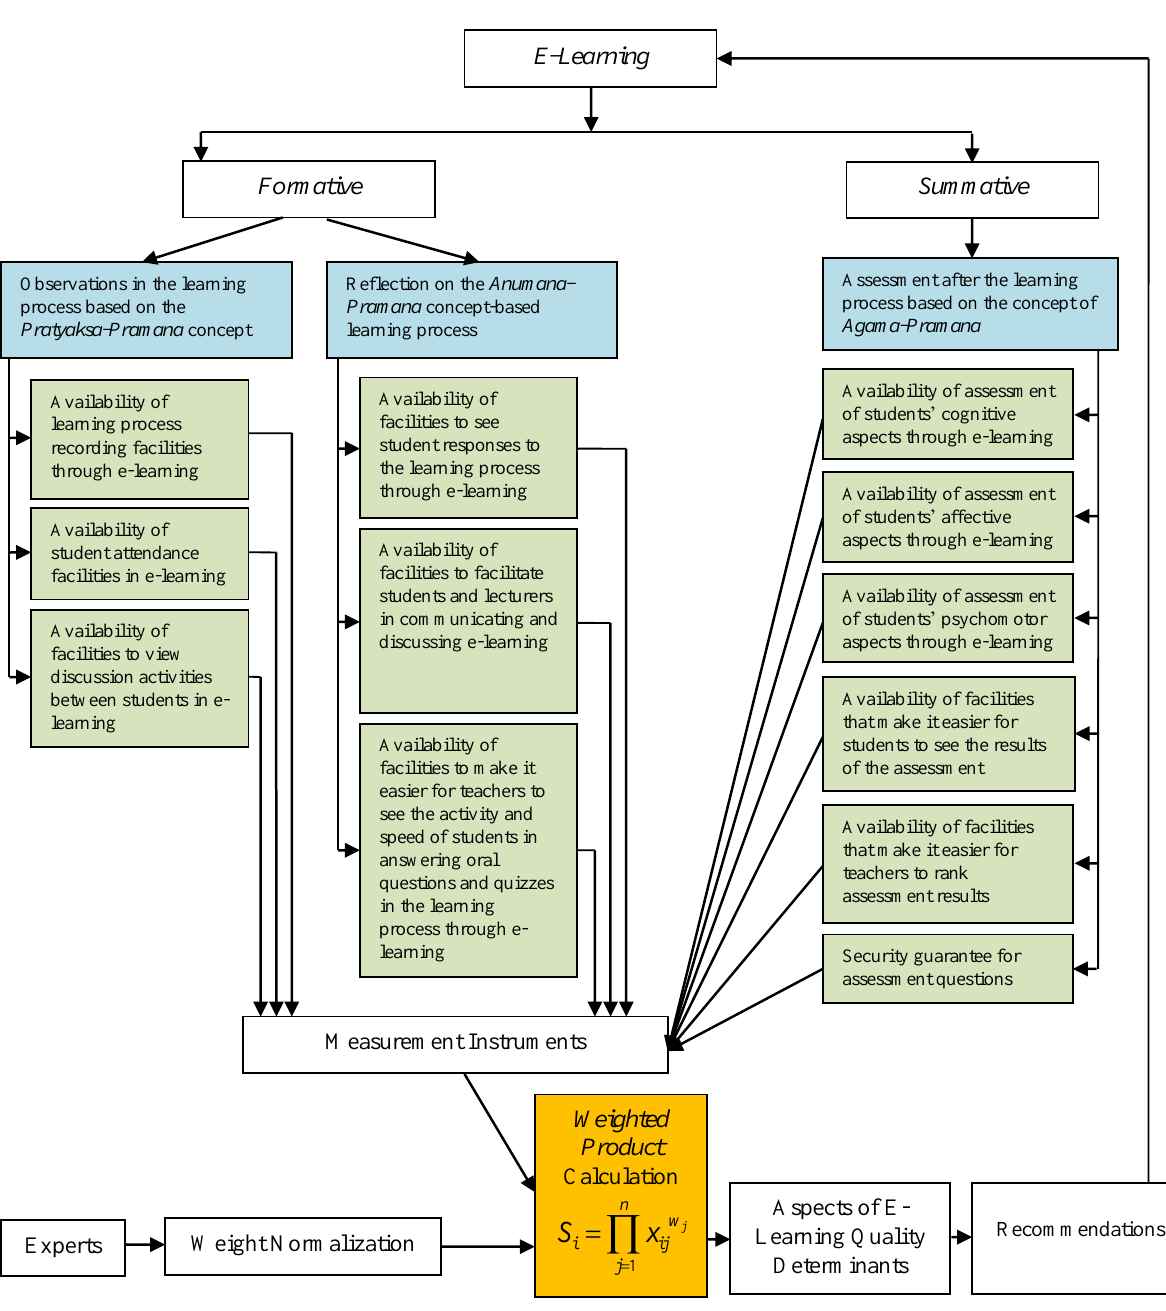
Figure 3. Final Design of Formative-Summative Evaluation Model Based on Tri Pramana-Weighted